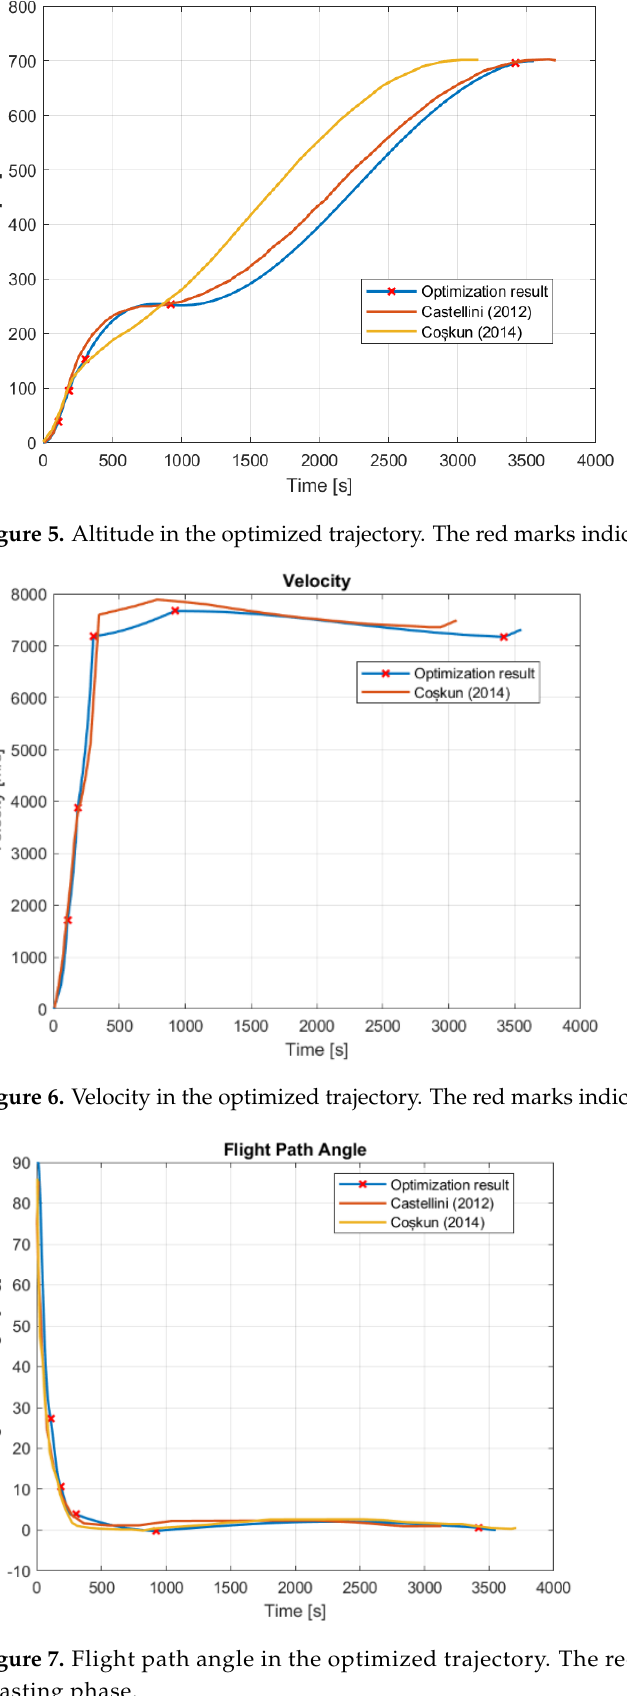
Figure 7. Flight path angle in the optimized trajectory. The red marks indicate the staging or coasting